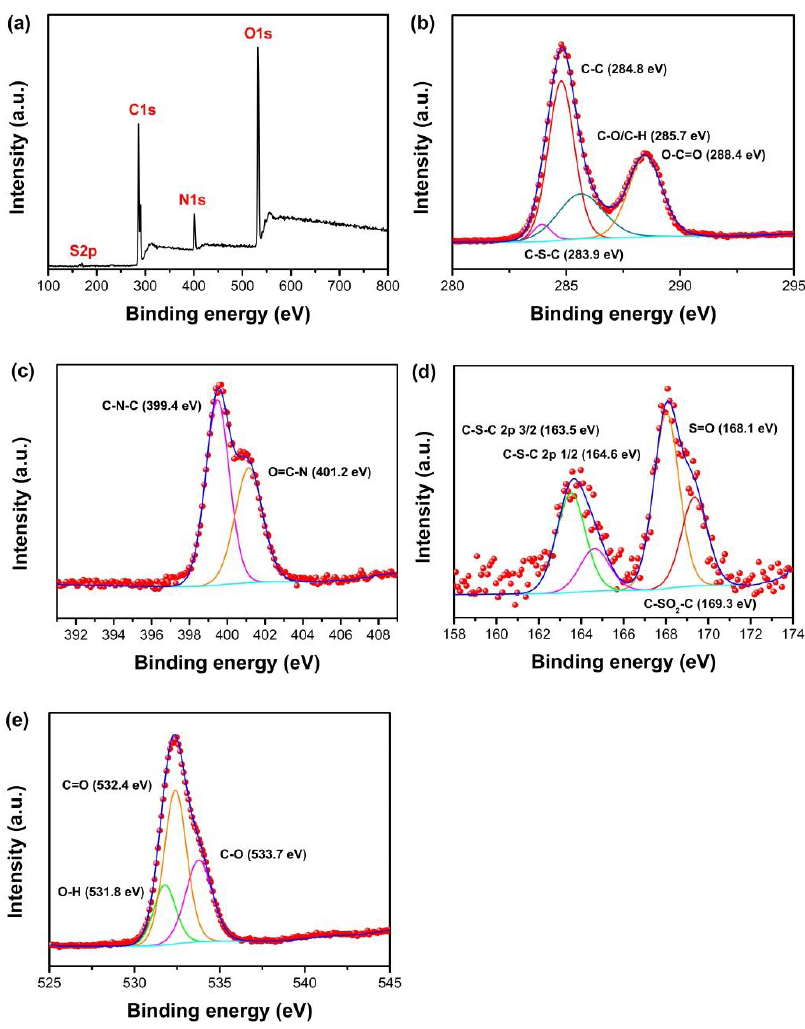
Figure 5. ( a ) The X-ray photoelectron spectroscopy (XPS) survey spectrum of N, S-GQDs, ( b – e ) high resolution spectra of C 1s, N 1s, S 2p, and O 1s of as-synthesized N, S-GQDs, respectively.